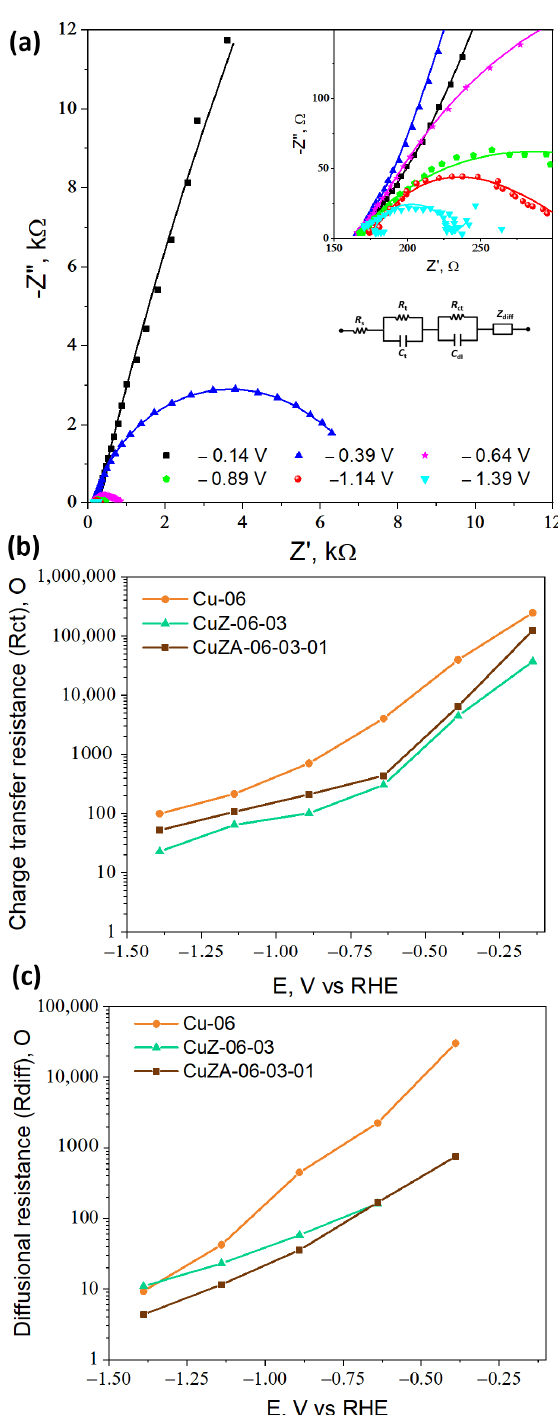
Figure 11. ( a ) Nyquist plots related to the CuZA-06-03-01 electrode measured at different potentials (V vs. RHE) in the CO 2 -purged electrolyte (the points are experimental data; the set of numbers are the curves calculated through a fitting procedure using the equivalent electrical circuit shown in the inset of ( a )). ( b ) Charge transfer resistances and ( c ) diffusional resistances reported as a function of the potential of the CuZnAl-oxide based electrodes.